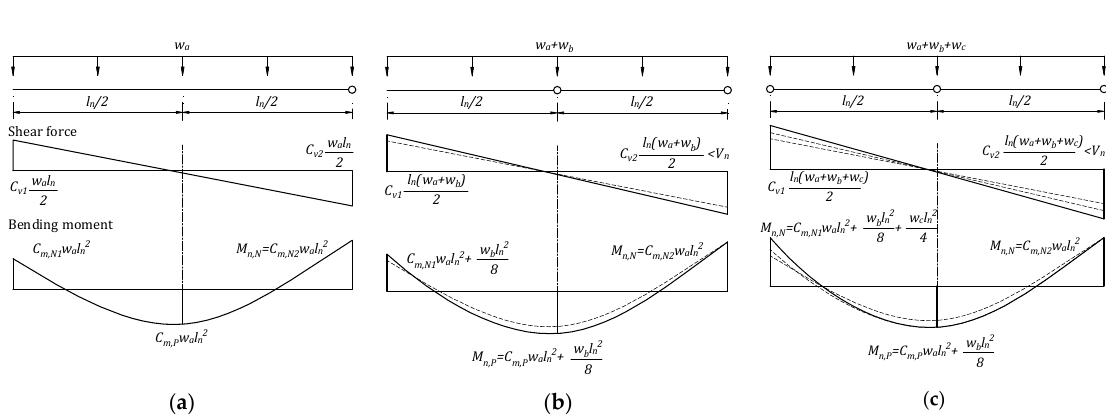
Figure A3. Failure mechanism for D-2 region. ( a ) Flexural failure at the N2 section first; next, ( b ) flexural failure at the mid-span section; and finally, ( c ) flexural failure at the N1 section.